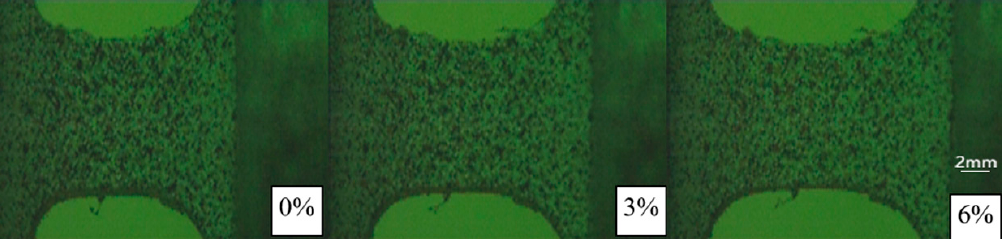
Figure 7. Deformation diagram of specimen corresponding to different strains at a temperature of 255 K.